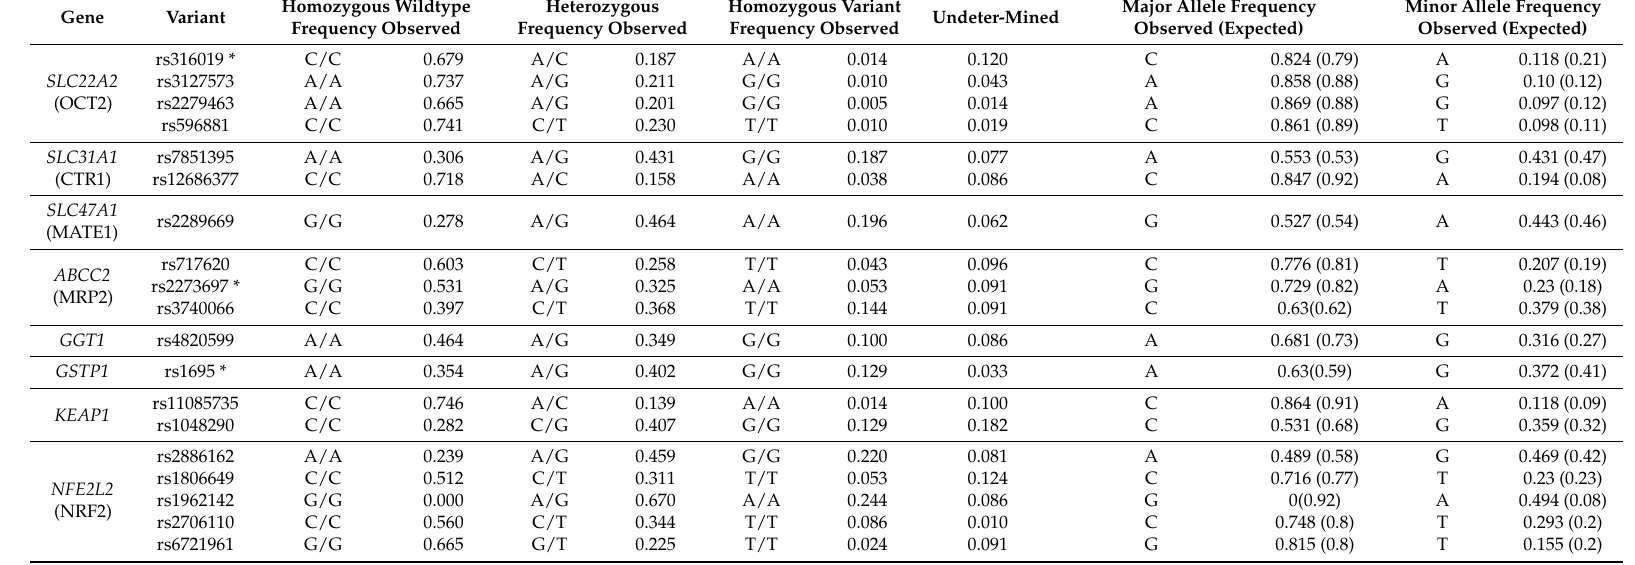
Table 2. Genotype and Allelic Frequencies for Transport, Metabolism, and Regulatory Genes Relevant to Cisplatin Disposition ( n = 206).